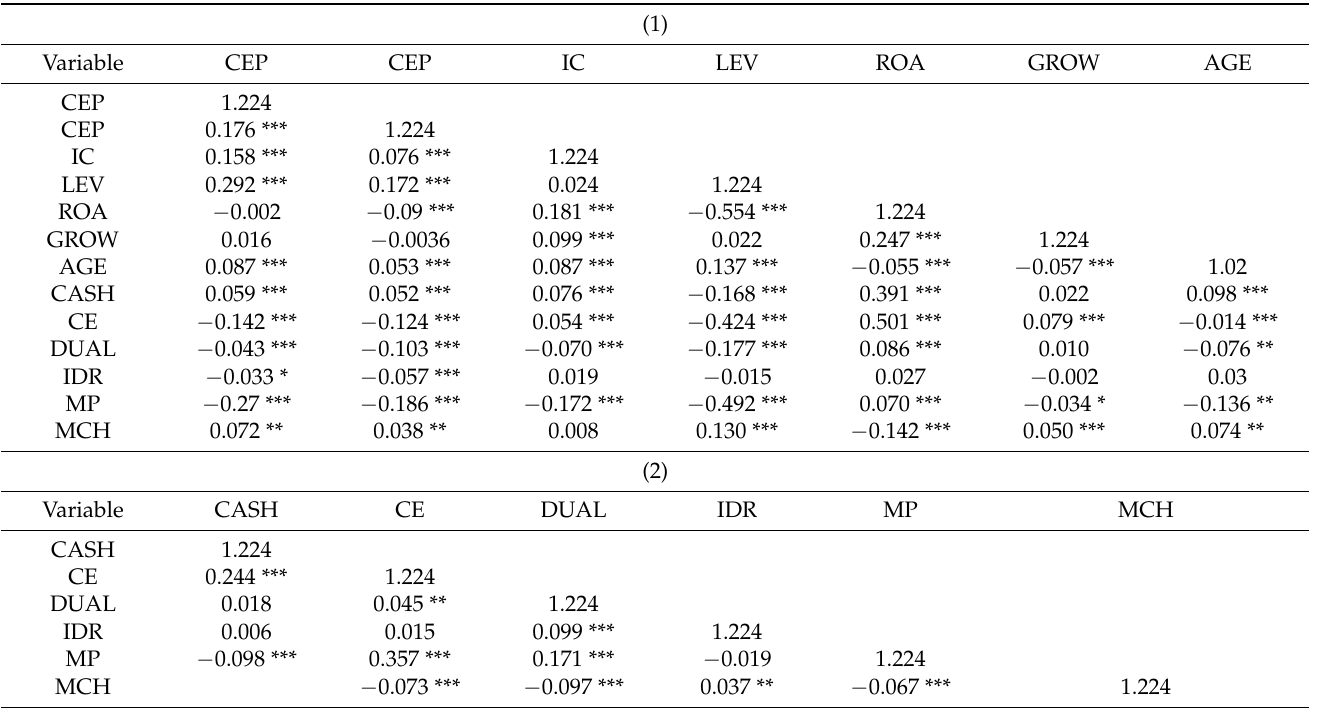
Table 3. Correlation Coefficient.